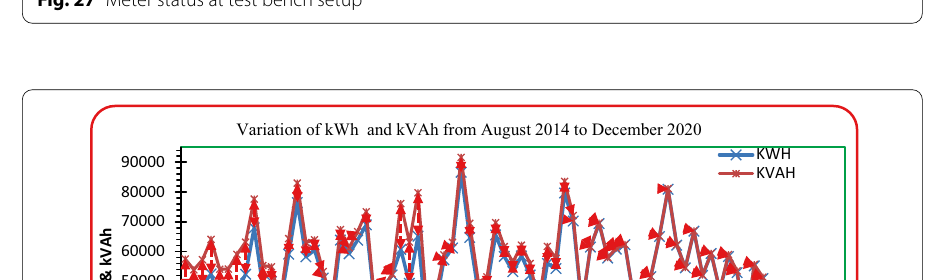
Fig. 27 Meter status at test bench setup